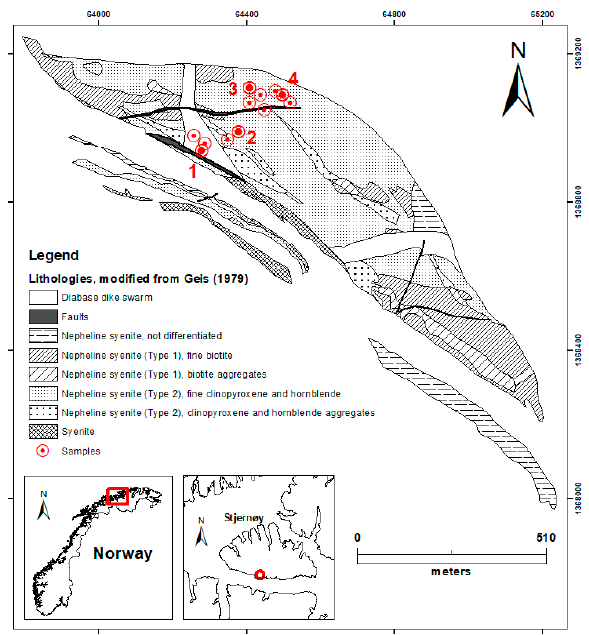
Figure 1. Geological map of the Nabbaren nepheline syenite deposit located at the south side of the Stjernøy Island. The positions of drill-holes selected for sampling are shown as red dots. The samples selected for EPMA analyses are indicated by numbers and have a thicker central mark. Geological map modified from Geis [17].